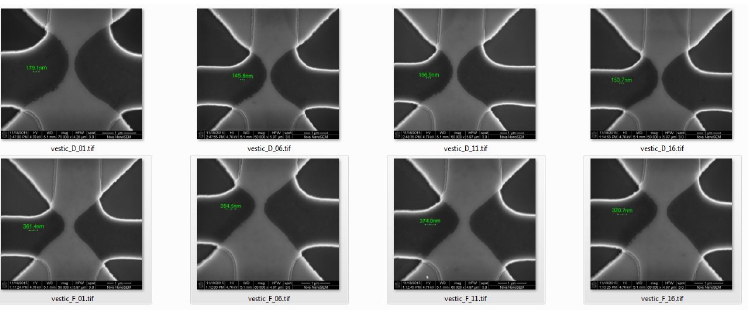
Figure 7. SEM photos of the slit regions with various shapes and minimum base widths w b 0 . (Cour- tesy of the Institute of Microelectronics and Photonics). (Courtesy of the Institute of Microelectronics and